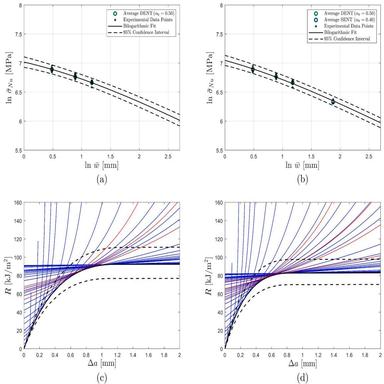
(a), (b) Bilogarithmic intrinsic size effect laws; and (c), (d) corresponding R-curves for two different specimen sub-sets from the entire data set.